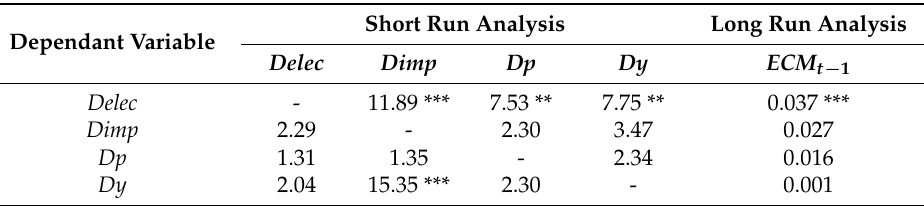
Table 6. Granger causality